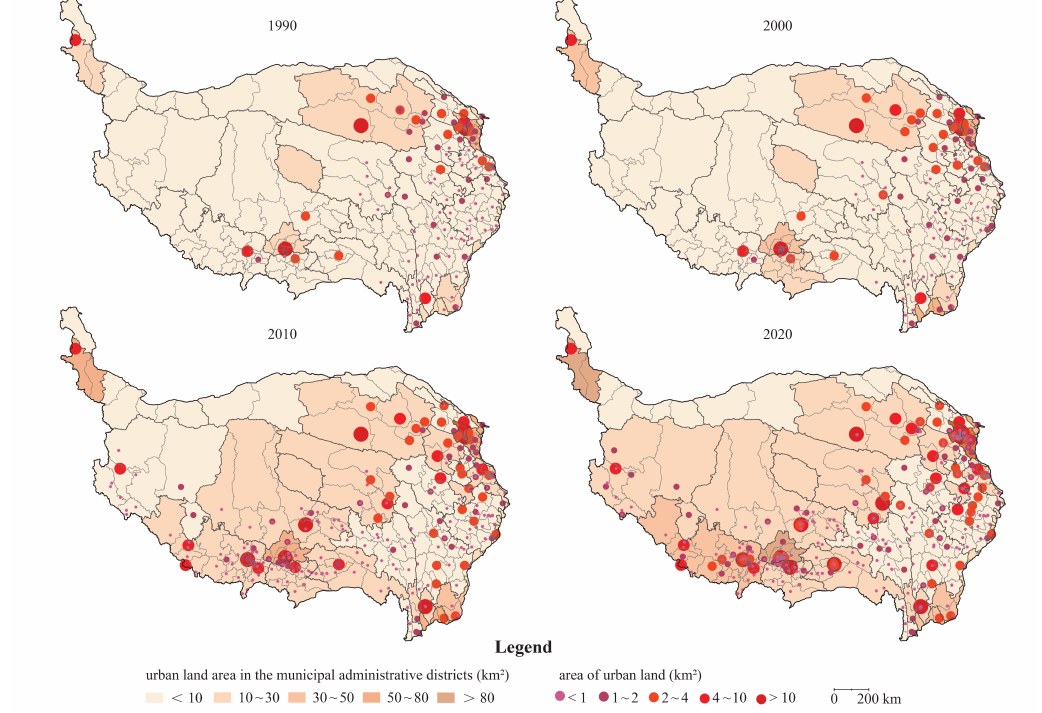
Figure 3. Changes of urban land use in the Qinghai–Tibet Plateau during